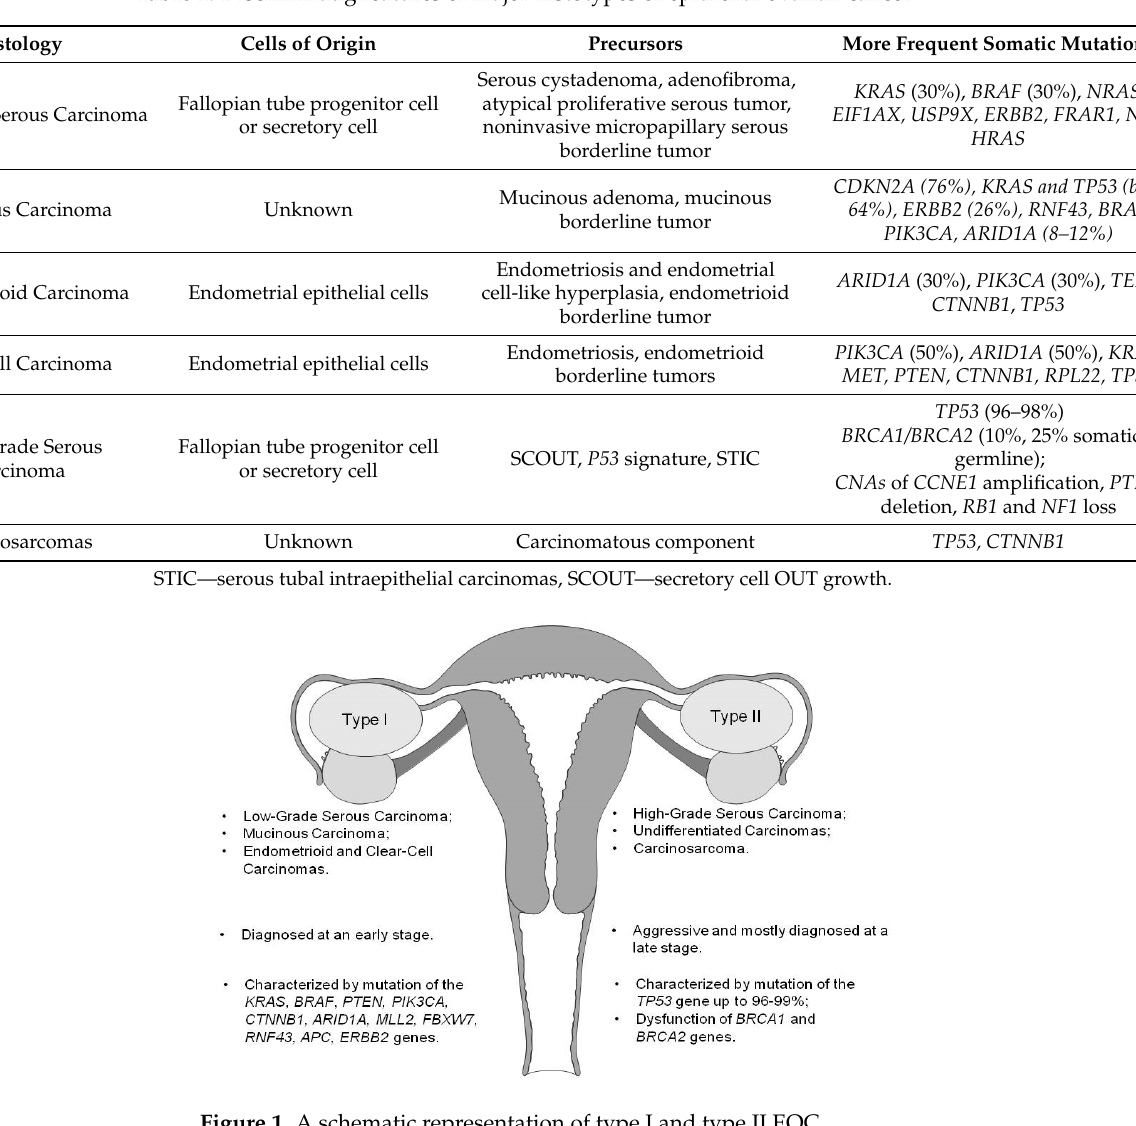
Table 1. Discriminatig features of major histotypes of epithelial ovarian cancer.